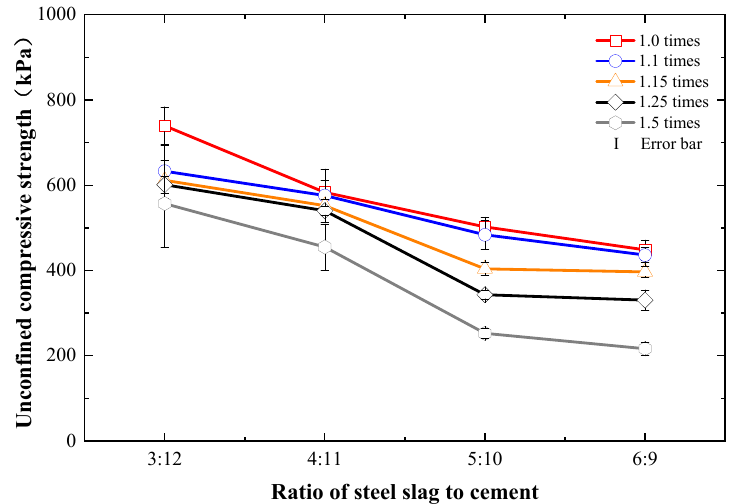
Figure 3. Compressive strength variations of cement- and steel-slag-stabilized dredged soils with different moisture contents and ratios of steel slag to replace cement. 3.2. Influence of Moisture Content on the Compressive Strength of Dredged Soils Stabilized by Cement and Steel Slag